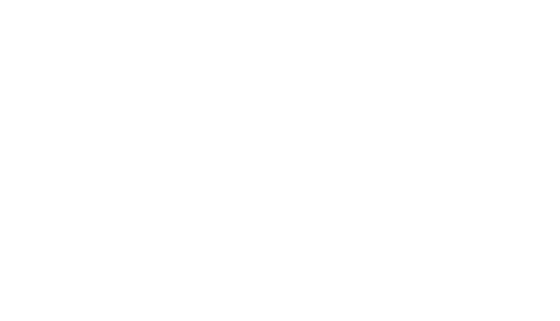
Table 6. Relevant indicators to be considered in the index and their